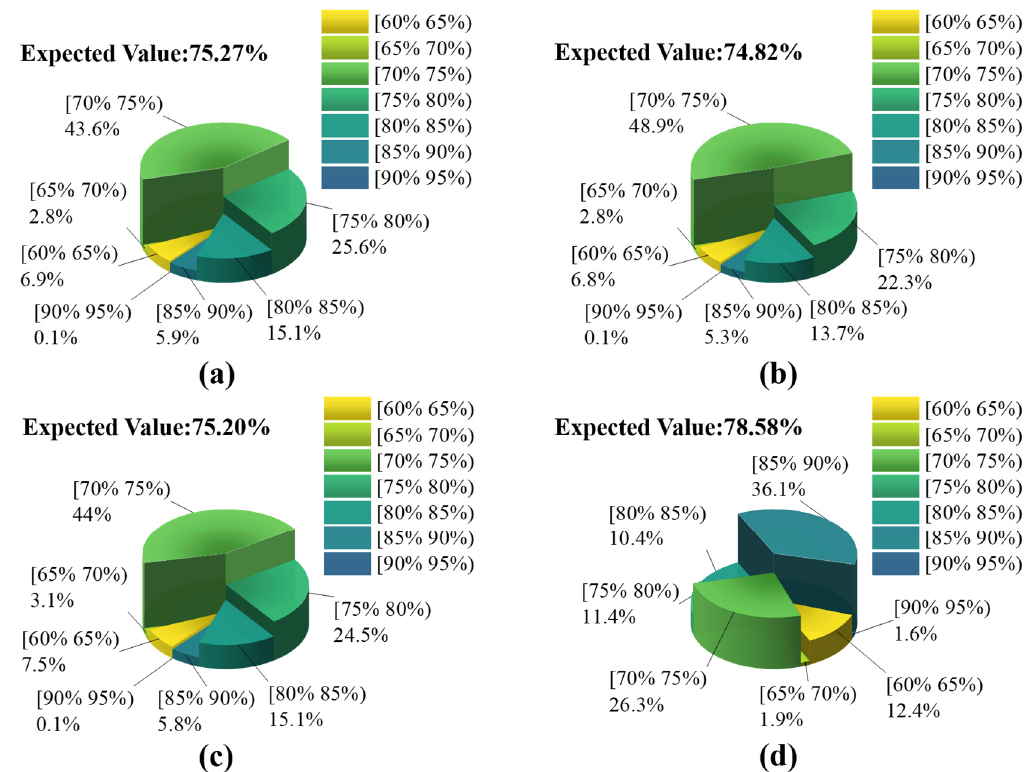
Figure 19. Efficiency distribution of rear motor operating points. ( a ) RB strategy; ( b ) ECMS strategy; ( c ) MPC strategy; ( d ) H-EMS